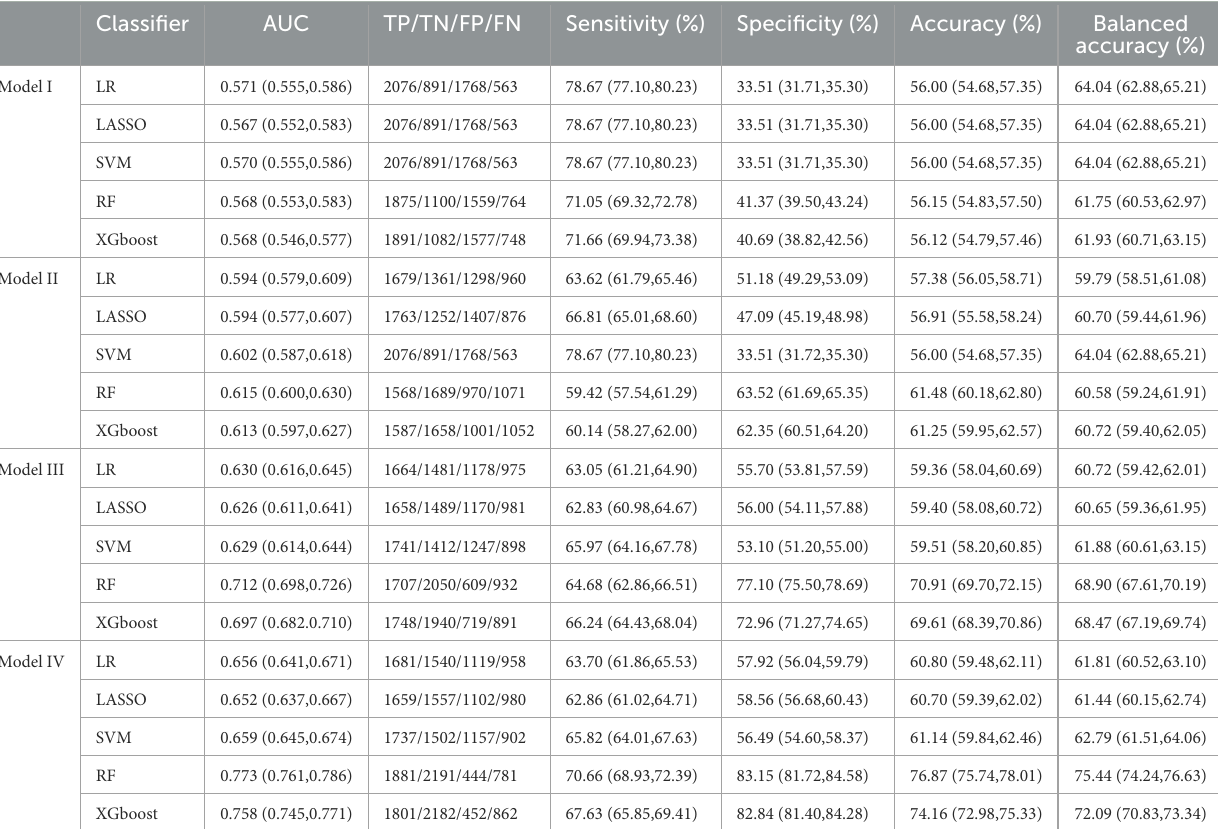
TABLE 2 Performance of machine learning models in prediction of the older adults’ demand for medical services provided by HCBS in CLHLS 2018.